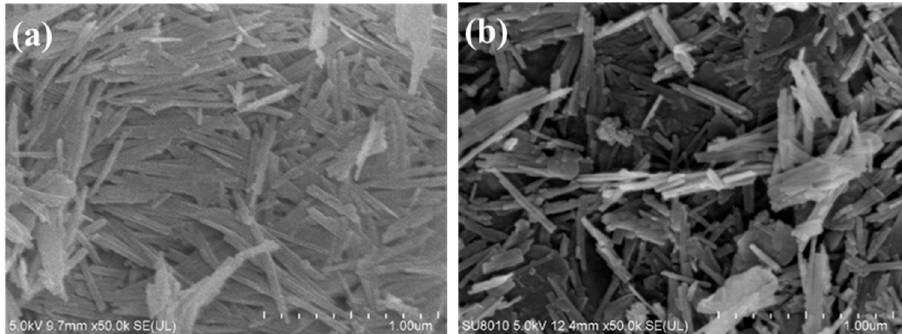
Figure 2. SEM images of ATP before modification ( a ) and after modification ( b ).